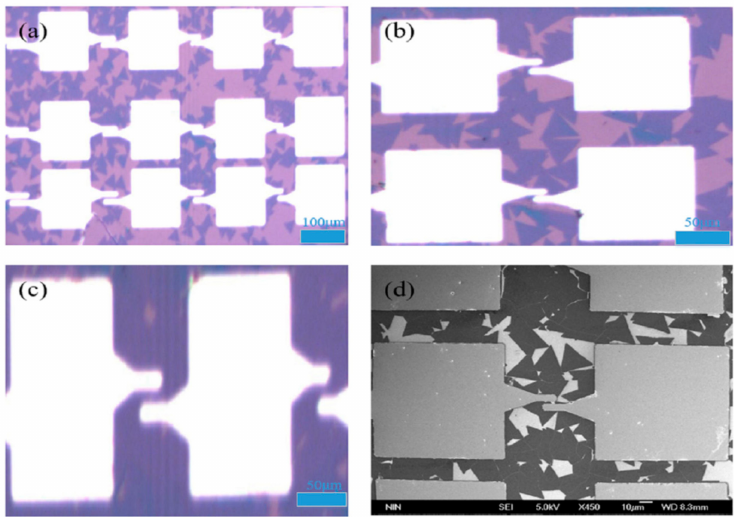
Figure 4. ( a ) The 10 × objective optical microscope image; ( b ) the 50 × objective optical microscope image; ( c ) the 100 × objective optical microscope image of the monolayer MoS 2 -based back-gate FET; and ( d ) the FESEM image of the monolayer MoS 2 -based back-gate FET.